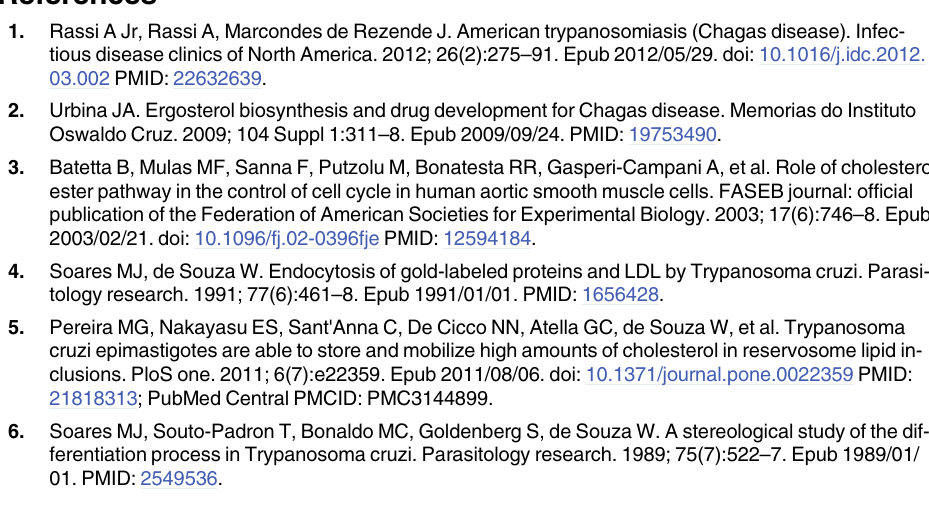
treated with Sandoz for 40h or Avasimibe for 48h, at the indicated concentrations, was evaluat- considered 100% viable in A and B. Parasites treated with the solvent (DMSO) were also evalu- ated. The results are expressed as the mean (±SD) of two independent experiments in dupli- cate. S2 Fig. Ultrastructure of Avasimibe treated epimastigotes. Cholesterol loaded epimastigotes, treated or not with 20 μ M Avasimibe for 48h, were processed for transmission electron micros- copy. We did not find any differences between membranes and organelles from untreated (A) and treated parasites (B — F). (B) Longitudinal section of a epimastigote presenting intact nu- cleus, kinetoplast, reservosomes, plasma membrane and flagellar pocket. (C) Transversal sec- tion showing reservosomes with lipid inclusions. Endoplasmic reticulum is closely associated with reservosomes. (D) Longitudinal section, with reservosomes and lipid droplets at the poste- rior end of the parasite. (E) Endoplasmic reticulum surrounding a lipid droplet adjacent to the nucleus. (F) Many lipid droplets and reservosomes. N — nucleus; K — Kinetoplast; FP — flagellar pocket; L — lipid droplet; R — reservosome; Cy — cytostome; F — flagellum; ER — endoplasmic re- ticulum. Bars correspond to 0.25 μ